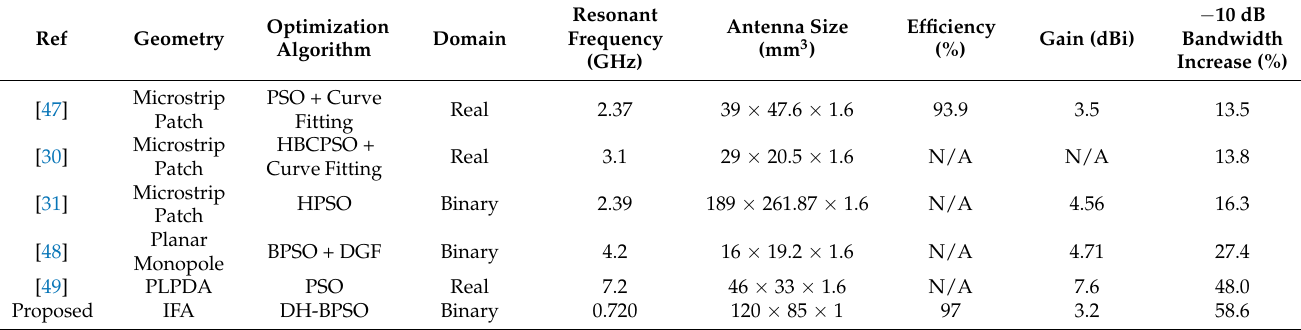
Table 5. Comparison of DHBPSO with other applications in literature of PSO algorithms towards bandwidth enhancement. Ref